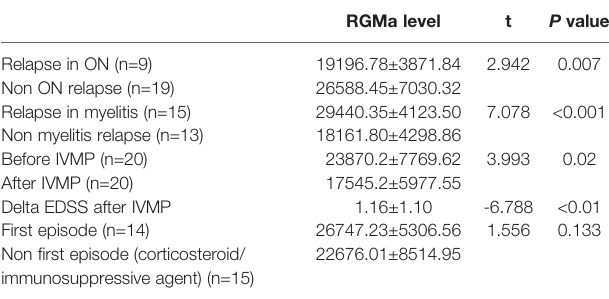
TABLE 4 | Comparison of RGMa level according to different clinical parameters.